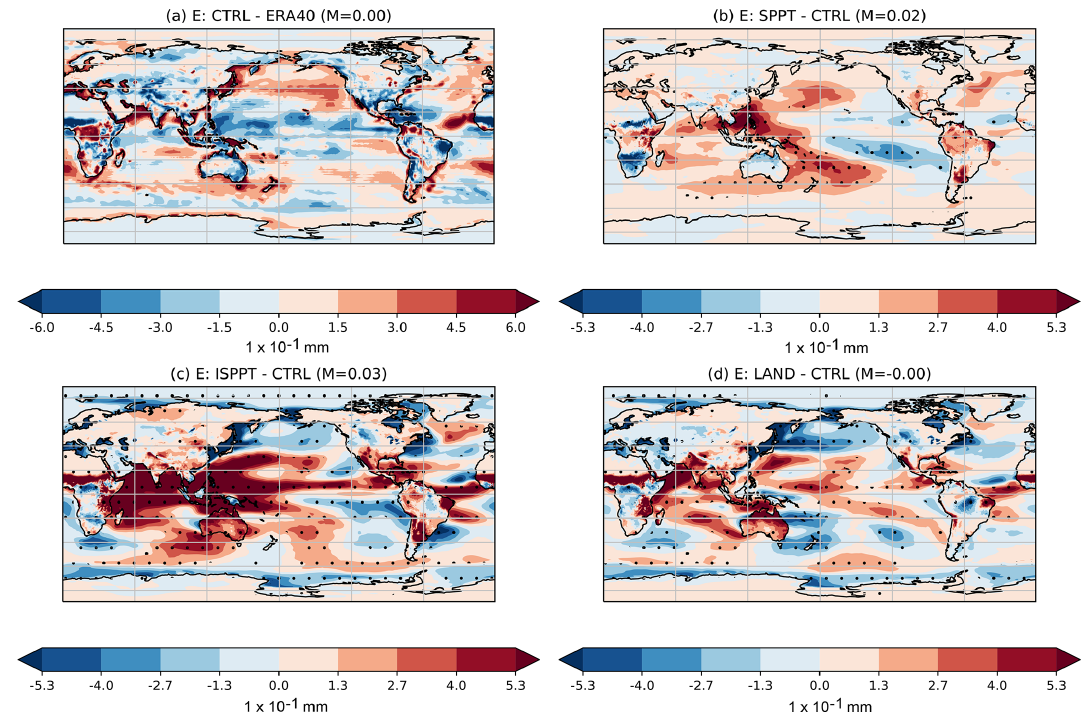
Figure 2. Mean differences in evaporation between the (a) CTRL and ERA40, (b) SPPT and CTRL, (c) ISPPT and CTRL, and (d) LAND and CTRL. Stippling indicates regions where the difference is statistically significant to the 95% confidence interval, as measured by a two-tailed t test. In each panel, M denotes the mean of the difference. Note the difference in the scales between (a) and (b, c, d)